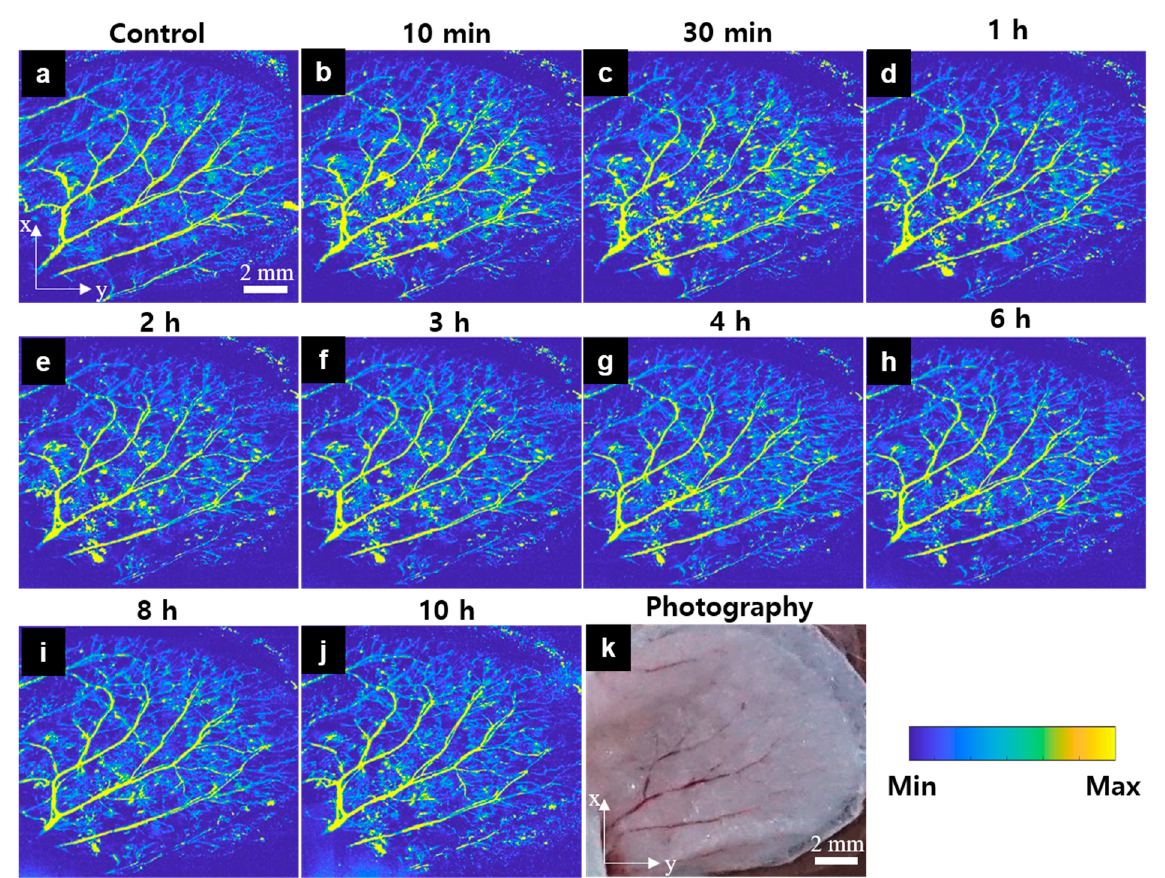
Figure 3. In vivo OR-PAM MAP images of the peripheral vasculatures of a mouse ear after carfilzomib solution injection (Movie 1). ( a ) OR-PAM MAP image before carfilzomib injection, ( b – j ) OR-PAM MAP images after carfilzomib solution injection during 10 h of observation, ( k ) Photograph of the corresponding mouse ear.